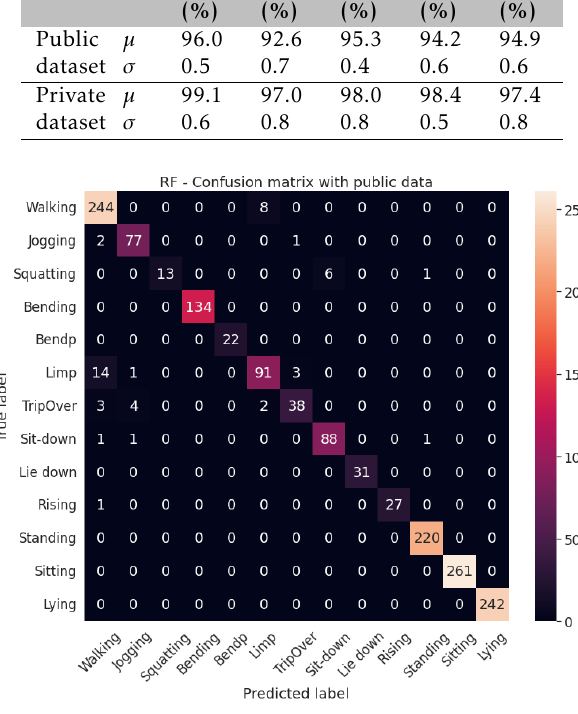
Fig 17. Classification result for RF algorithm on public data.